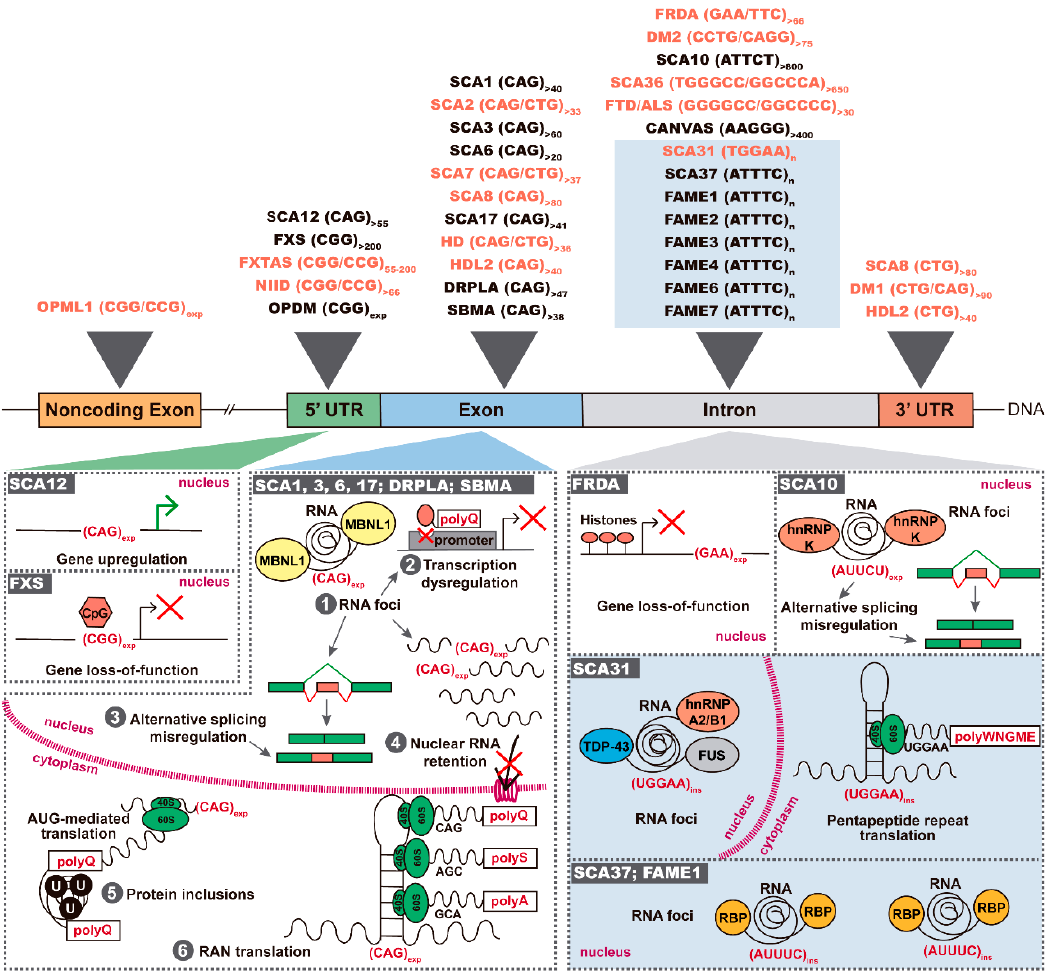
Figure 1. Repeat expansions and insertions causing neurodegenerative and neuromuscular diseases. Top: pathogenic repeat expansions spread over 5 ′ and 3 ′ UTRs, exons and introns; novel repeat insertions are highlighted in a blue box; bidirectional transcription is known for the disorders in orange. Bottom: in SCA12, a 5 ′ UTR (CAG) n expansion leads to gene upregulation, whereas expanded (CGG) n leads to CpG hypermethylation with silencing of FMRP expression in FXS; coding transcripts containing the expanded (CAG) n are able to (1) sequester RBPs such as MBNL1, forming nuclear RNA foci, which causes dysregulation of several cellular processes like (2) transcription, (3) mRNA splicing, (4) nucleocytoplasmic transport; in the cytoplasm, coding repeat expansions are (5) translated in proteins with expanded polyQ tracts leading to ubiquitin-positive (U) inclusions in neurons, or are (6) RAN-translated in polypeptides; in FRDA, a biallelic intronic (GAA) n expansion leads to repressive chromatin with consequent gene silencing; in SCA10, the (ATTCT) n is transcribed forming nuclear RNA foci with hnRNP K; in SCA31, nuclear RNA foci colocalize with TDP-43, FUS and hnRNP A2 / B1 and pentapeptides are produced. PolyQ-polyglutamine; polyS-polyserine; polyA-polyalanine; polyWNGME-poly-tryptophan-asparagine-glycine-methionine-glutamic acid.